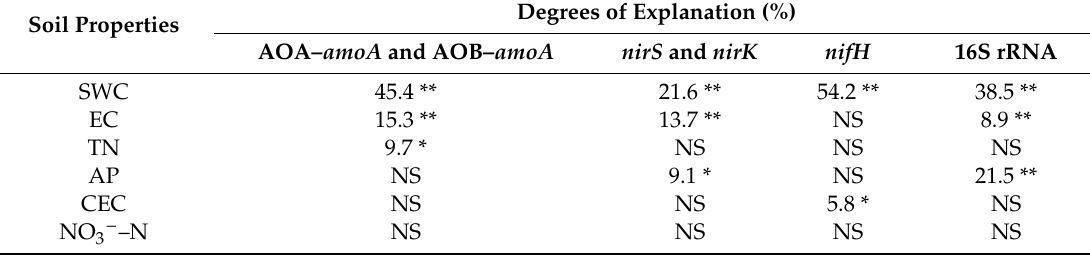
Results for RDA testing e ff ects of soil properties on the community structures of ammonia–oxidizers ( amoA ), denitrifying bacteria ( nirS and nirK ), N–fixing bacteria ( nifH ), and total bacteria (16S